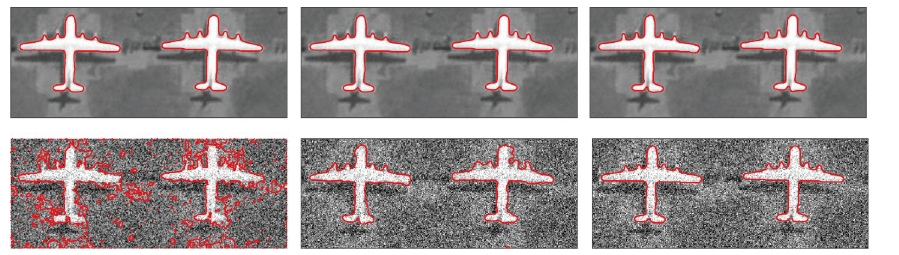
Fig 5. Comparisons of the proposed model with the CV model and the LVC model.